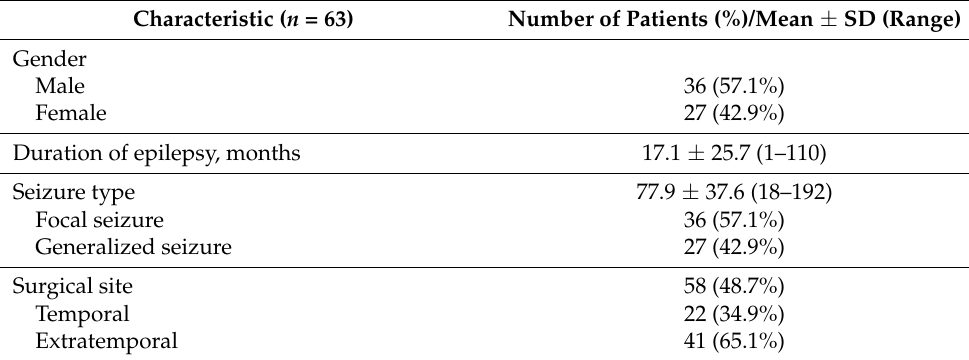
Table 1. Characteristics of children with failed resection